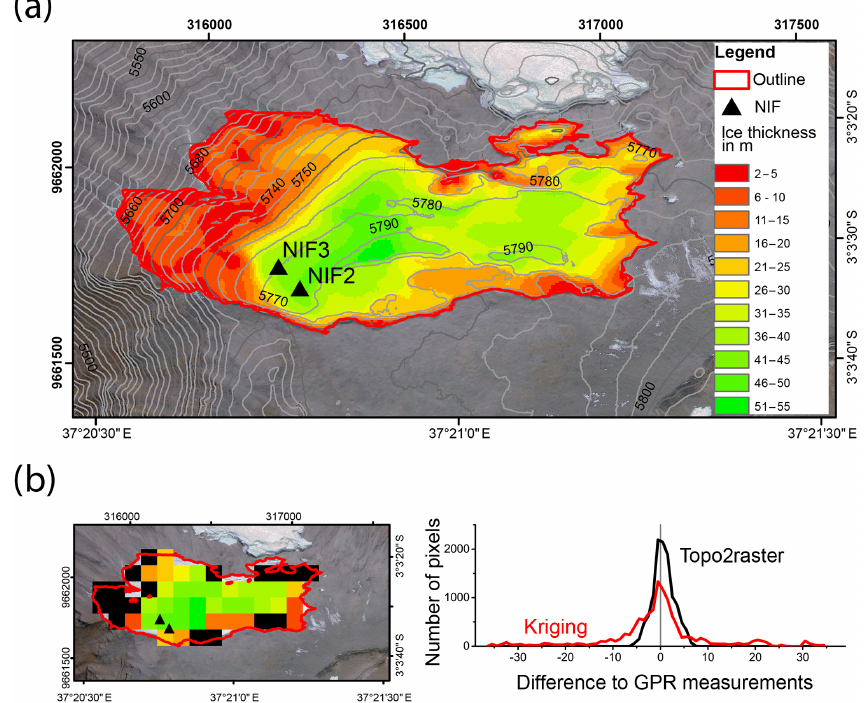
Figure 7. Interpolated ice thickness based on GPR profiles and the digital elevation model (a) . The maximum ice thickness is around 53.5m in approximately the centre of the glacier, in association with the highest elevation. The bottom row (b) shows the result of the alternative interpolation method by kriging. Due to sparse coverage by GPR, kriging had to be applied at coarse resolution. Black squares indicate zero ice thickness. Shown on the right side is the value distribution of the difference calculated between GPR measured and interpolated ice thickness at GPR data points unused for interpolation (see text). Coordinates are in UTM 37M.